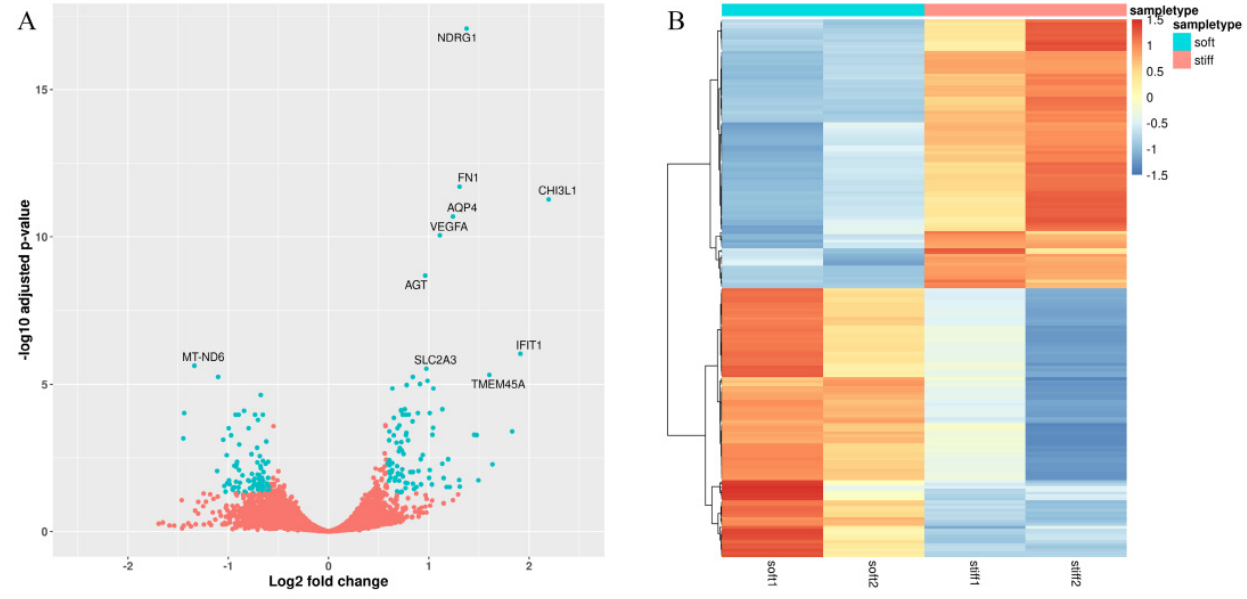
Figure 1. Volcano and heatmap of stiffness − dependent genes. ( A ) Volcano plot for all DEGs. Red dots indicate genes that were not significantly expressed, whereas green dots indicate significantly expressed genes. The 10 most significant DEGs are highlighted with gene names. ( B ) Heatmap of DEGs. Up − regulated genes are denoted by yellow − red colors and down − regulated genes are denoted by navy − blue colors.